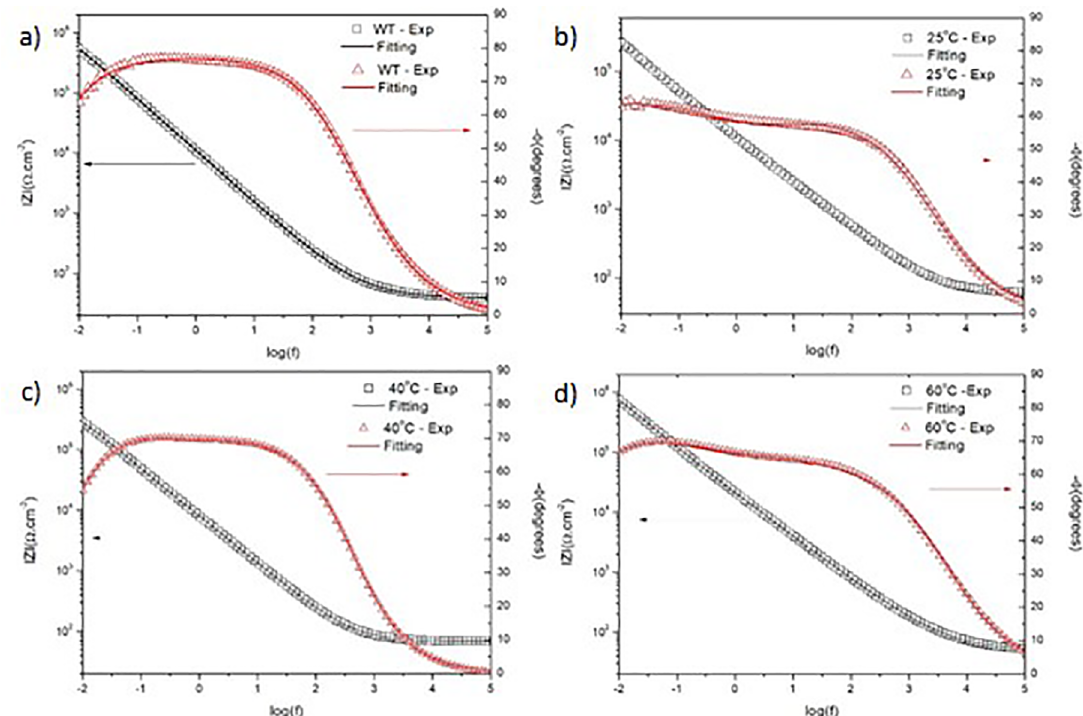
Figure 12 . Bode plots of Ti6Al4V with experimental and fitted data. (a) untreated control and (b–d) samples etched by piranha solution for 30 min at 25 °C, 40 °C, and 60 °C, respectively. Table 4. Electrical parameters of equivalent circuit obtained by fitting experimental results of EIS. R e (Ω.cm 2